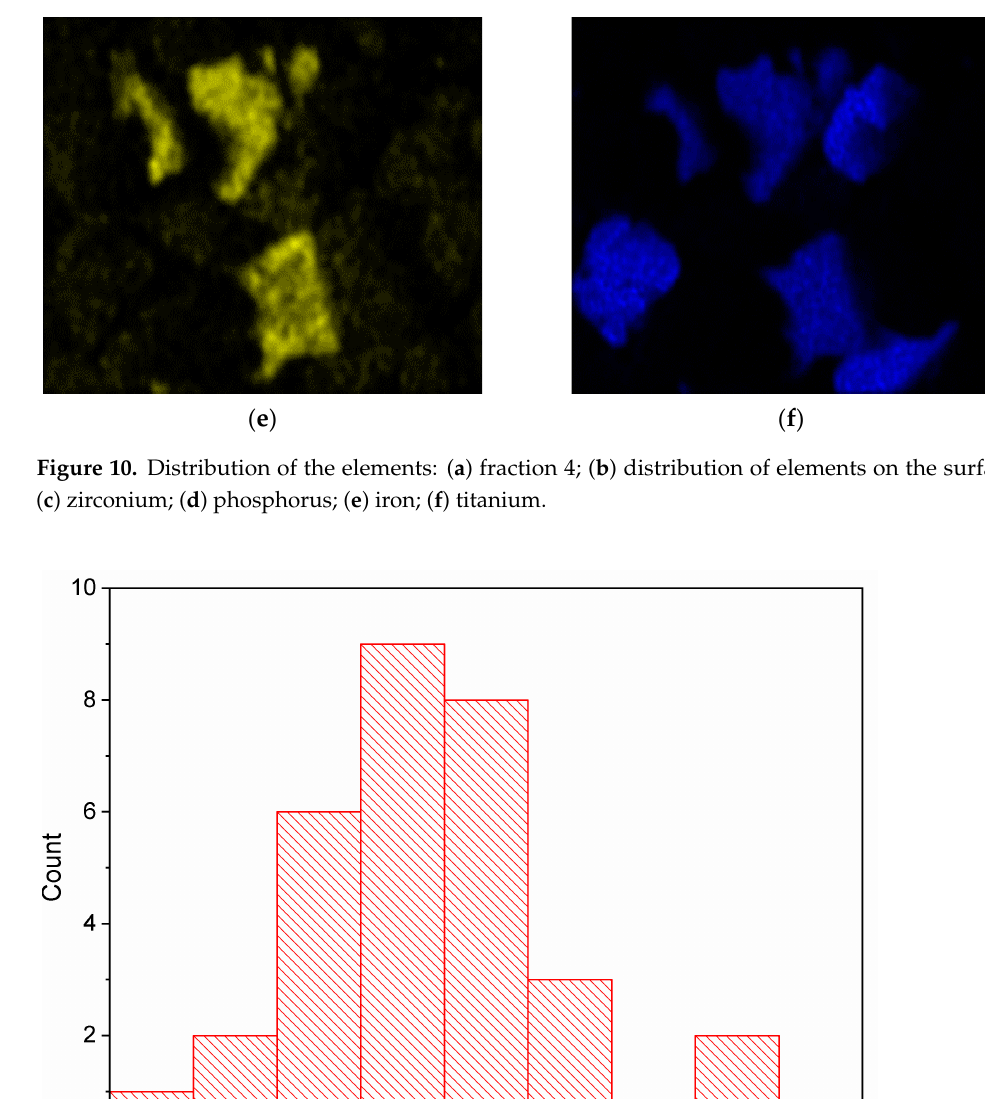
Figure 11. Particle size distribution.